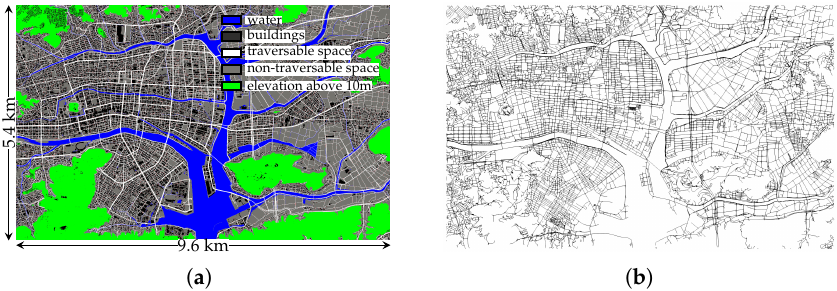
Figure 8. Grid and graph of 9.6 km × 5.4 km coastal region used for the demonstrative simulation. ( a ) 1 m × 1 m resolution grid, ( b )